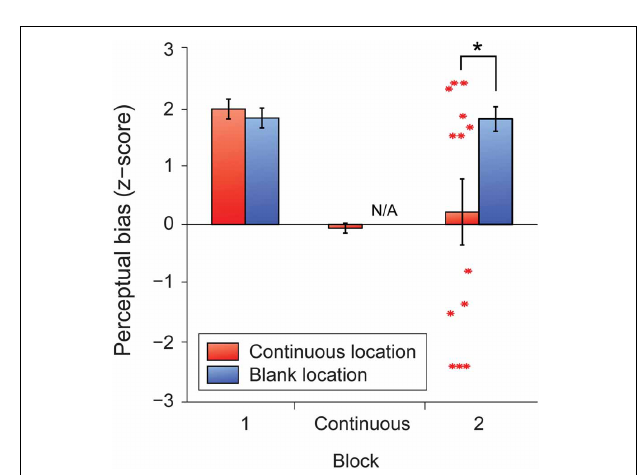
location (counterbalanced across subjects) continuously for 5min, during which they reported perceptual alternations in the perceived direction of stimulus rotation. At the end of the continuous interval, observers completed a final block consisting of 120 ambiguous trials.